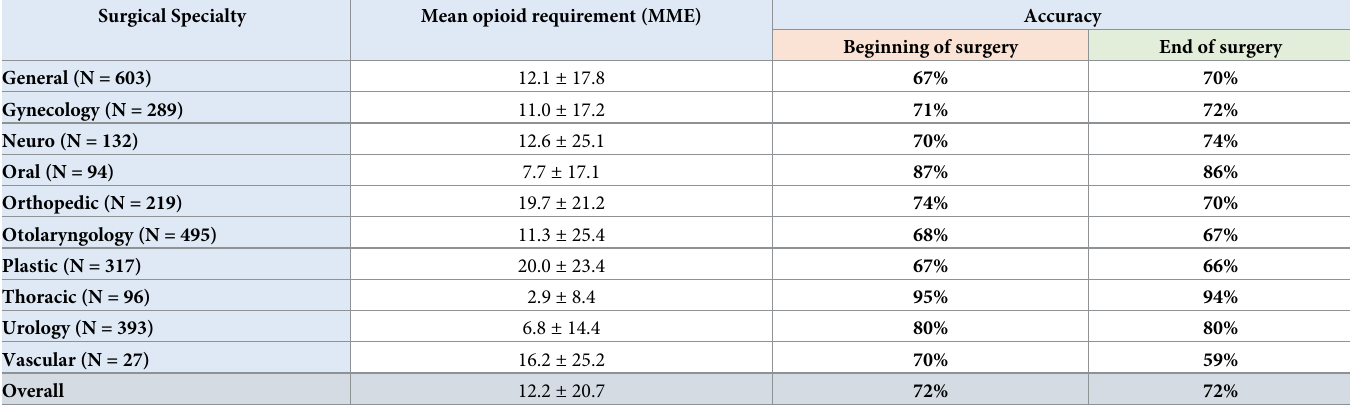
Table 5. Detailed prediction accuracies of random forest model for different categories of surgeries and aggregate opioid requirements. Prediction accuracies prior to and after surgery are shown. Surgical